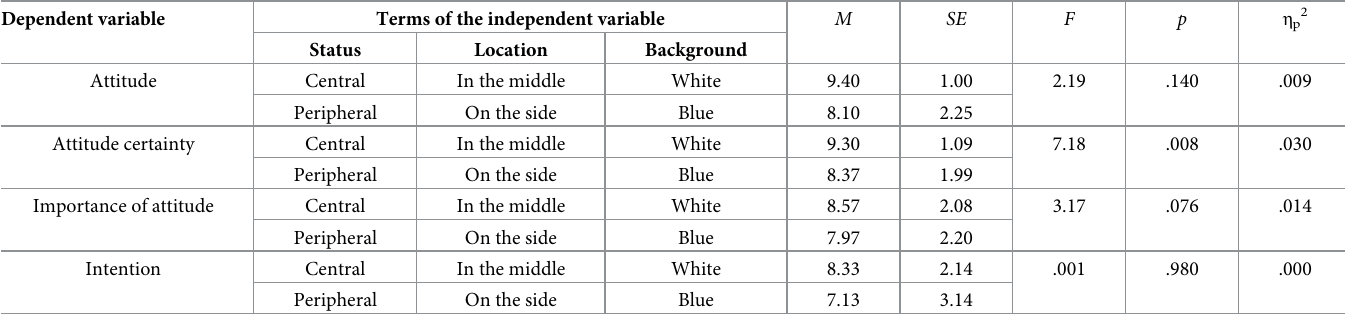
Table 5. Summary of three-way Status x Location x Background interaction effects.